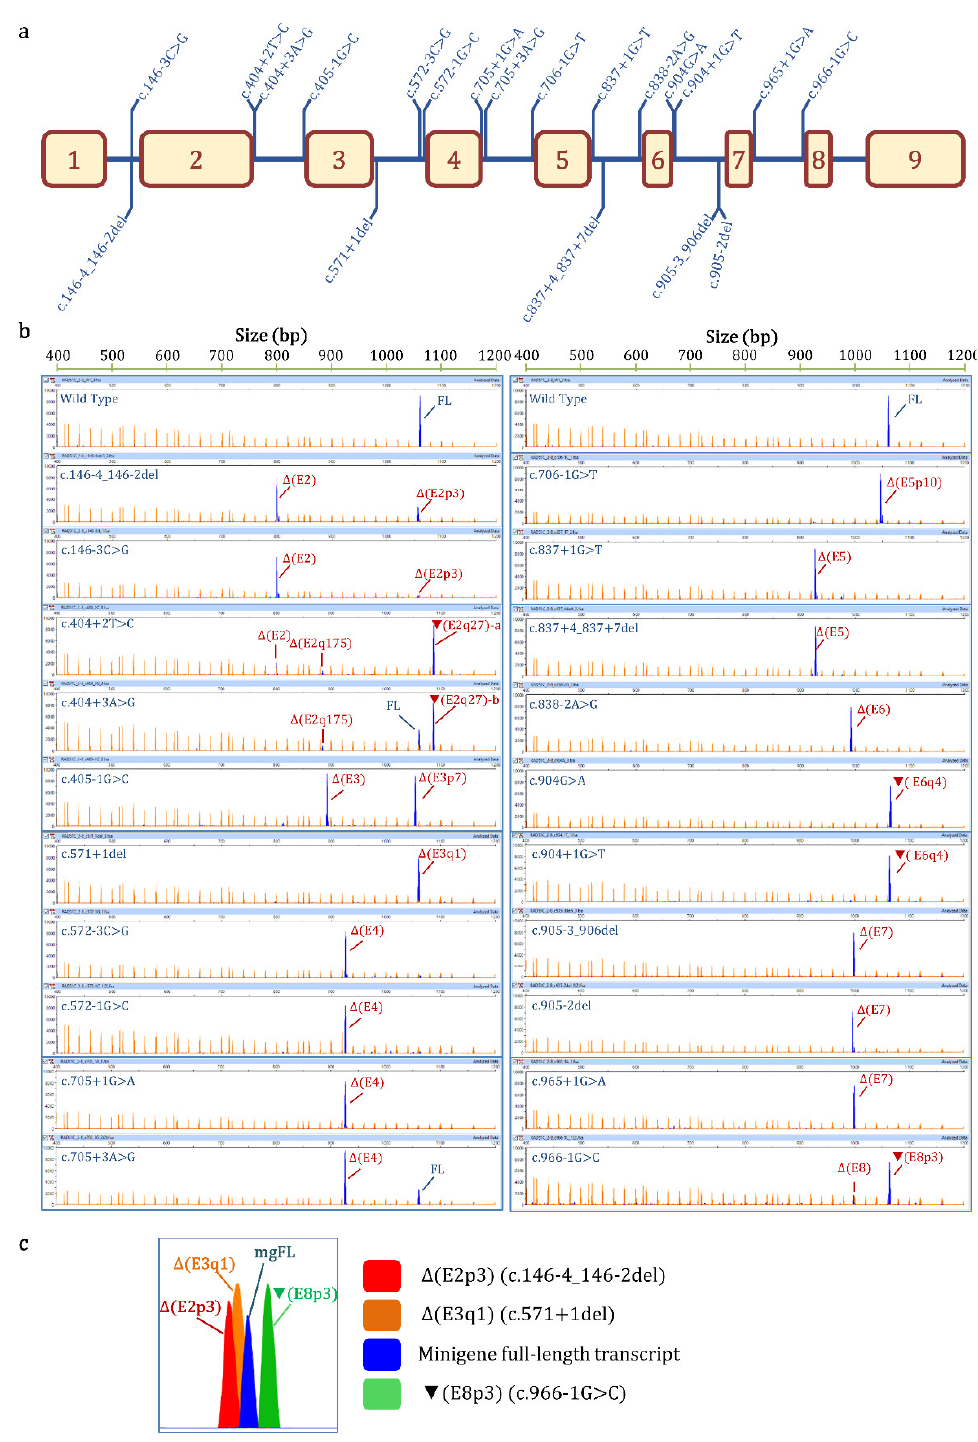
Figure 1. Minigene splicing assays of selected ClinVar variants. ( a ) Map of variants in the minigene mgR51C_ex2-8. ( b ) Fluorescent fragment analysis of the ClinVar variants. FAM-labelled products (blue peaks) were run with LIZ1200 (orange peaks) as size standard (FL, minigene full-length transcript). ( c ) High-resolution image of fluorescent fragment electrophoresis that discriminates minimal size differences between